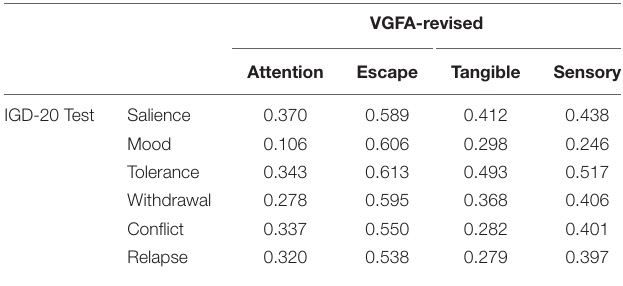
TABLE 2 | Correlation coefficients between levels of the VGFA-R and IGD-20 test.